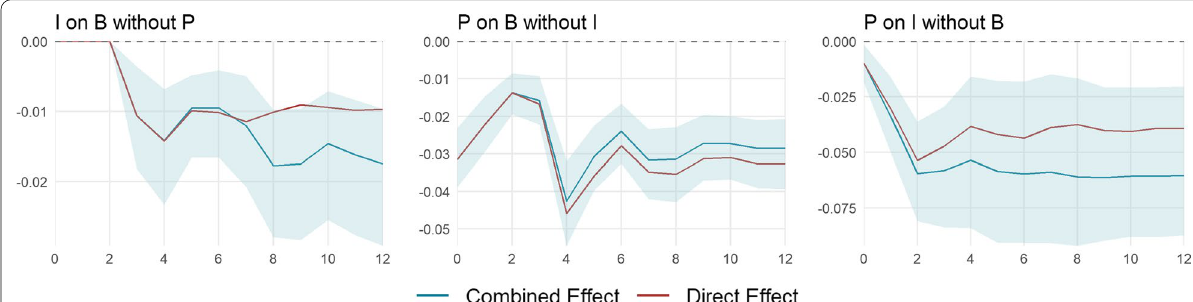
Fig. 8 Cumulative impulse responses with indirect channels shut off. The impulse responses are estimated using the recursively ordered VAR(4) in ln R e with cantonal fixed effects (blue). The red lines represent the cumulative effect when 3 and P (cid:31) KSI + , B (cid:31) lnNTRX , and I (4) with k = = = = the effect through the third variable in the system is artificially shut off. The data span September 28, 2020, until April 18, 2021. The shaded areas represent the 95% confidence intervals based on a wild bootstrap procedure with 5000 repetitions. The horizontal axes depict the time horizon in weeks. The vertical axes show the level response of lnNTRX (left and middle) and lnNINF